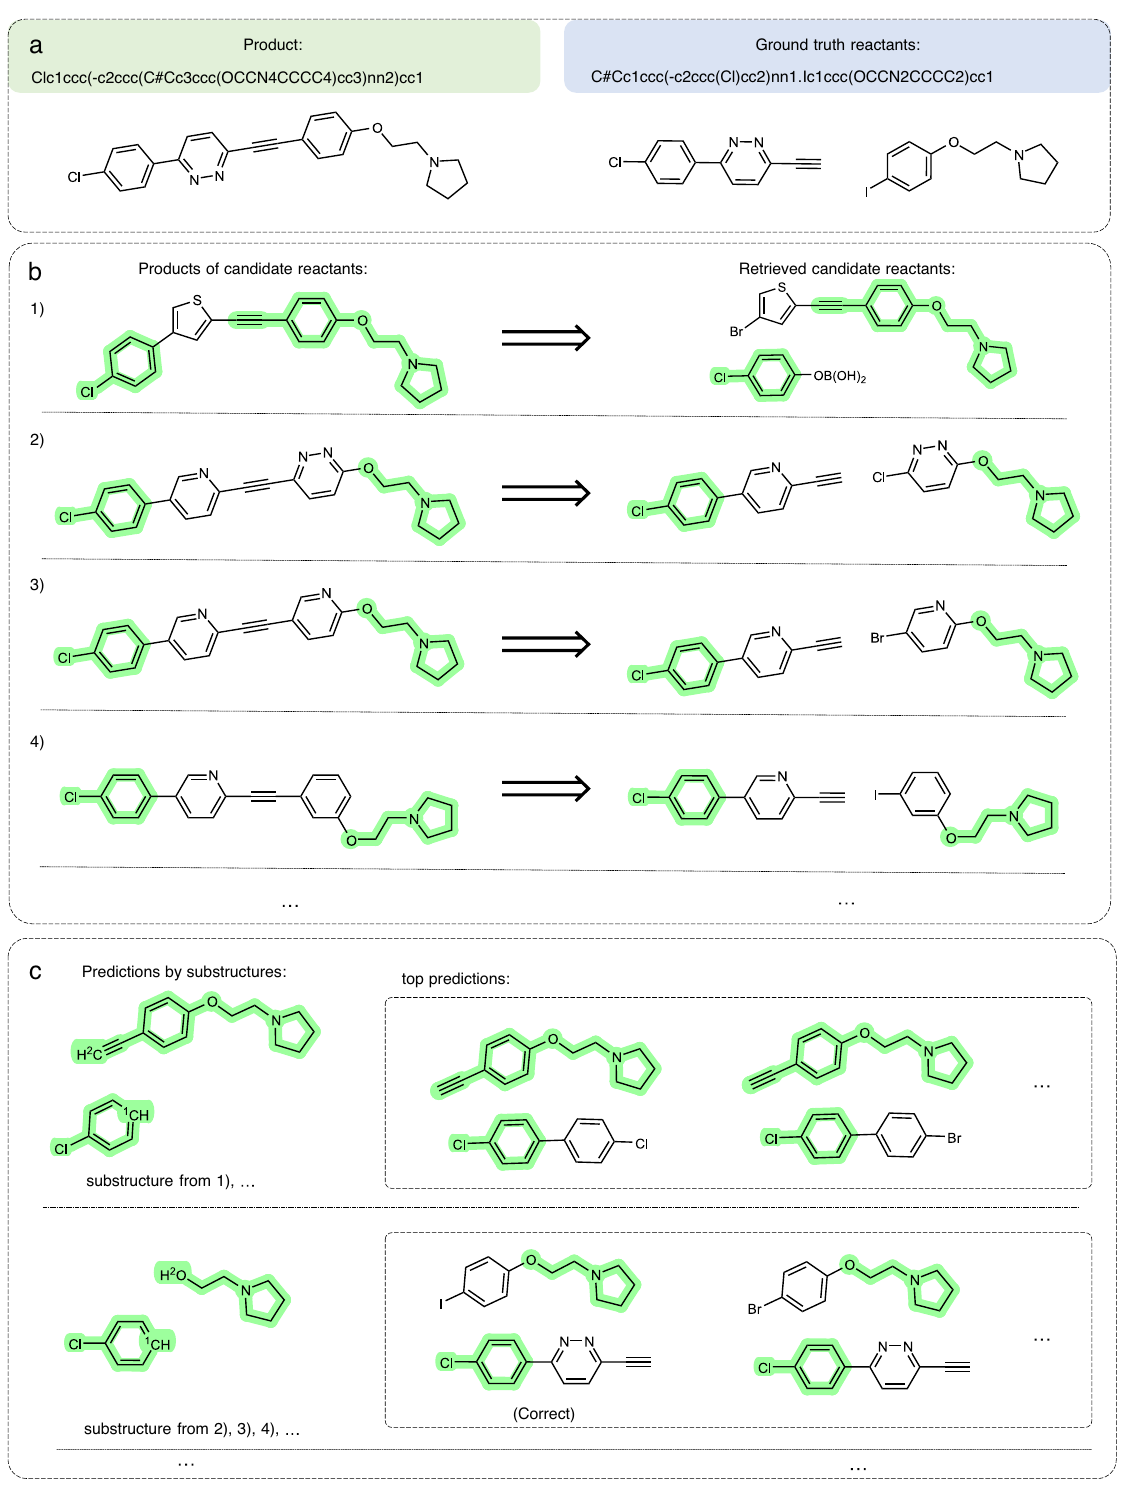
Fig. 2 | Substructures and predictions groupedby substructures. The retrieved candidate reactants (#2,#3and #4)indicate that the substructures extracted from the retrieved reactant #1 is likely incorrect, because the triple bond is likely a